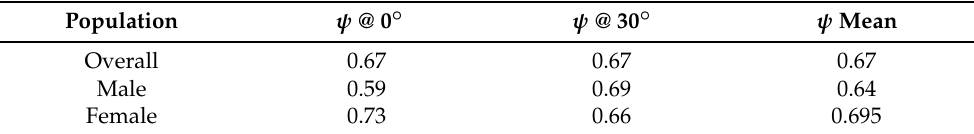
Table 6. Overall coefficient ψ for different weights, trunk inclinations, and gender populations. Population